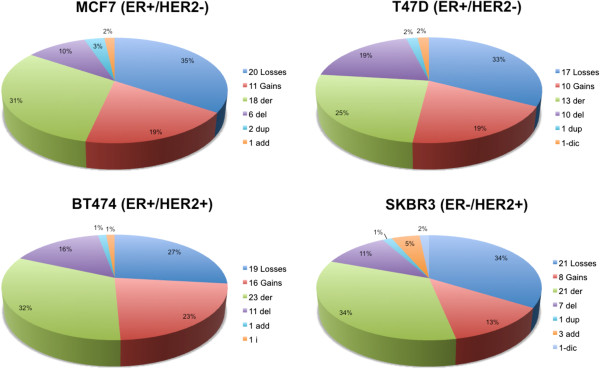
Distribution of numerical and structural aberrations across the four breast cancer cell lines. der = derivative chromosome; del = deletion; dup = duplication; add = additional material of unknown origin; dic = dicentric chromosome.